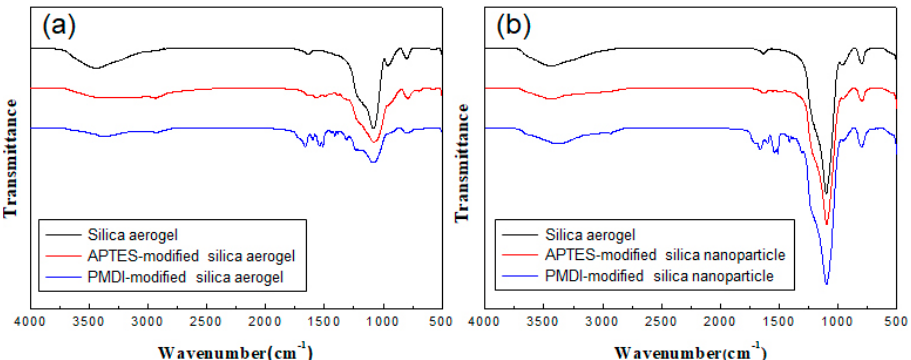
Figure 1. FT-IR spectra of silica aerogels ( a ) and silica nanoparticles ( b ) with and without surface modification.